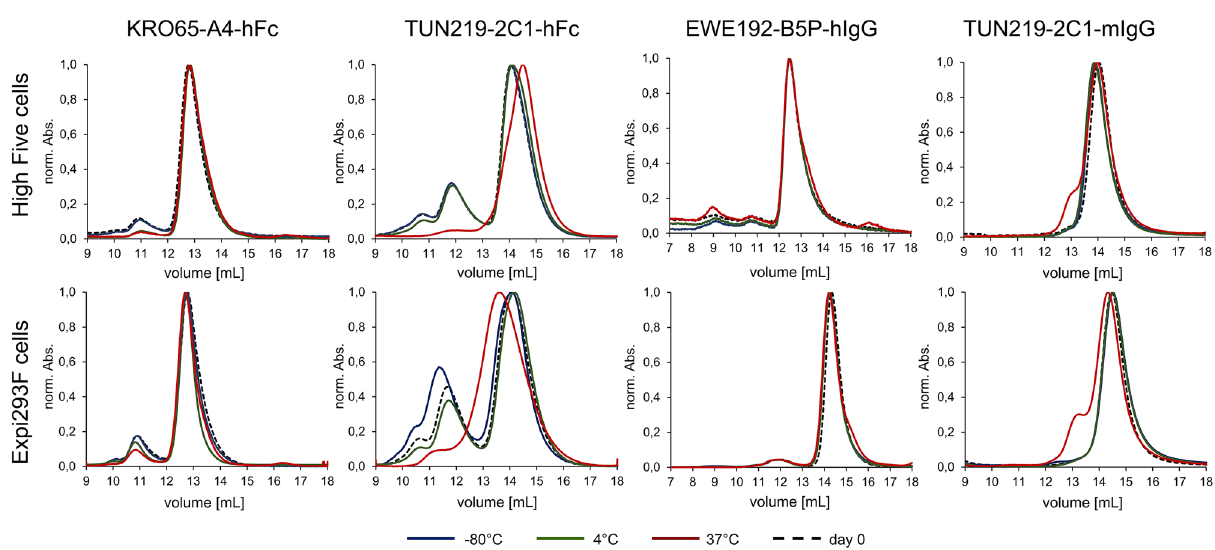
Figure 5. Analytical SEC profile to access aggregation behaviour. The indicated four different antibodies produced in High Five cells or in Expi293F cells were analysed on SEC immediately after production and after 30 days of storage at the indicated